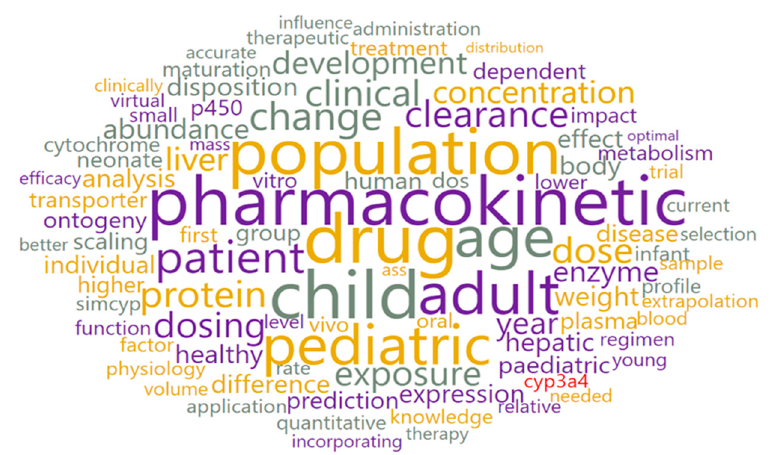
Figure 12. Word cloud for topic 3.